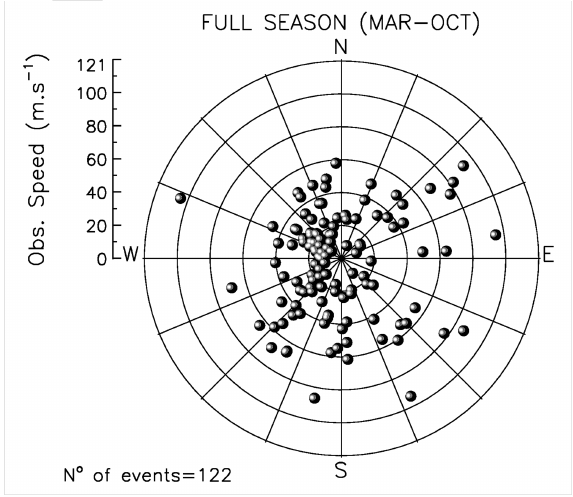
Figure 7. Polar chart of the gravity wave propagation direction as a function of the horizontal phase